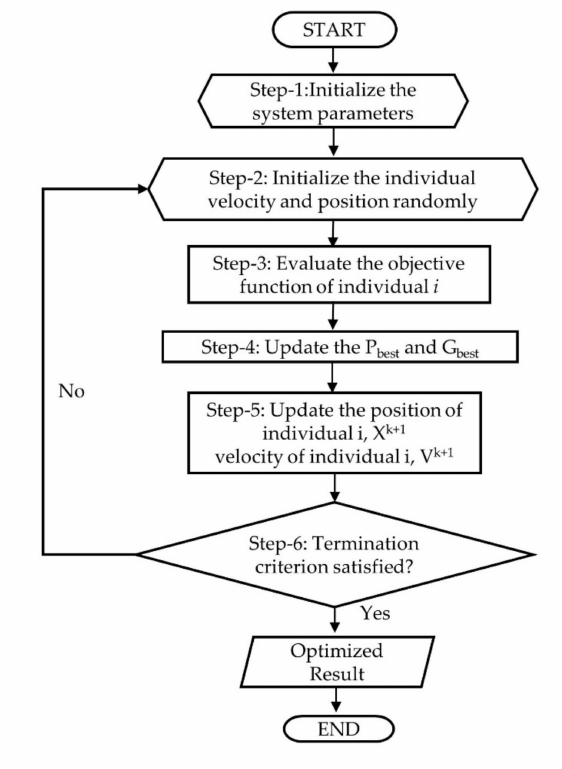
Figure 6. Flowchart of optimization